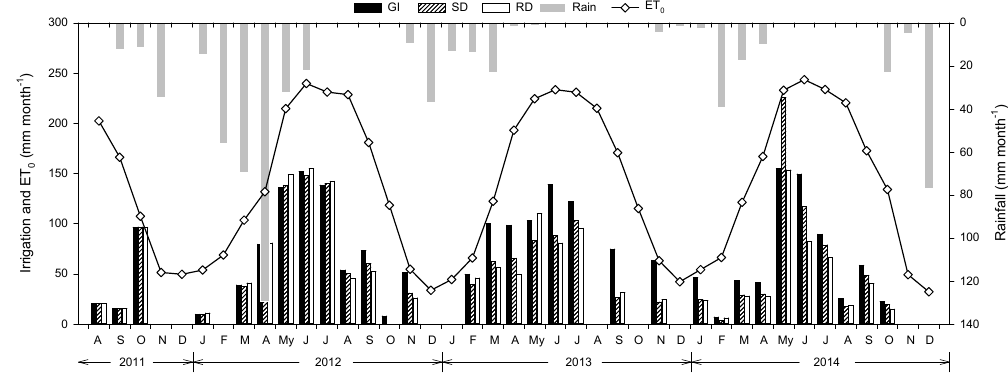
Figure 1. Monthly irrigation water applied in each treatment (GI—grower irrigation, SD—sustained deficit, RD—regulated deficit), rainfall and reference crop evapotranspiration (ET o ) from 2011 to 2014. To ensure that the plant has adequate water for early season growth and development and delay the time of the first irrigation, growers of perennial crops in the SJV typically try to have a full soil water profile in the root zone prior to bud break in the spring. This is done using a combination of rainfall and irrigation. In this area, the rainfall period extends from dormancy of the previous year to bud break in the current year. Growers will estimate and apply the irrigation water needed to supplement rainfall and fill the soil water profile prior to bud break. To capture this practice, we divided the crop water use calculations in Table 2 into two periods; from harvest the previous year to bud break in the current year, and from bud break to dormancy in the current year (growing season). We found that the combined rainfall and irrigation data in Table 2 averaged across years and treatments is approximately 198 mm. This amount of applied water was adequate to fill the crop root zone in these soils prior to bud break.